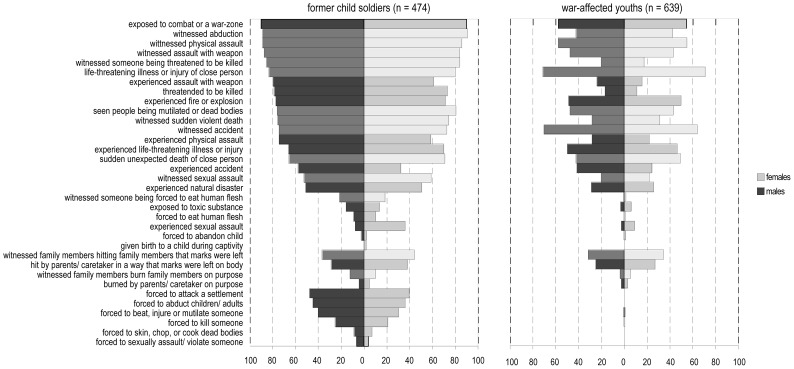
Frequencies of Traumatic Event-types for Former Child Soldiers and War-affected Youths by Gender.
Note. Lighter shades of grey within gender indicate witnessed event-types, darker shades of grey indicate experienced event-types.